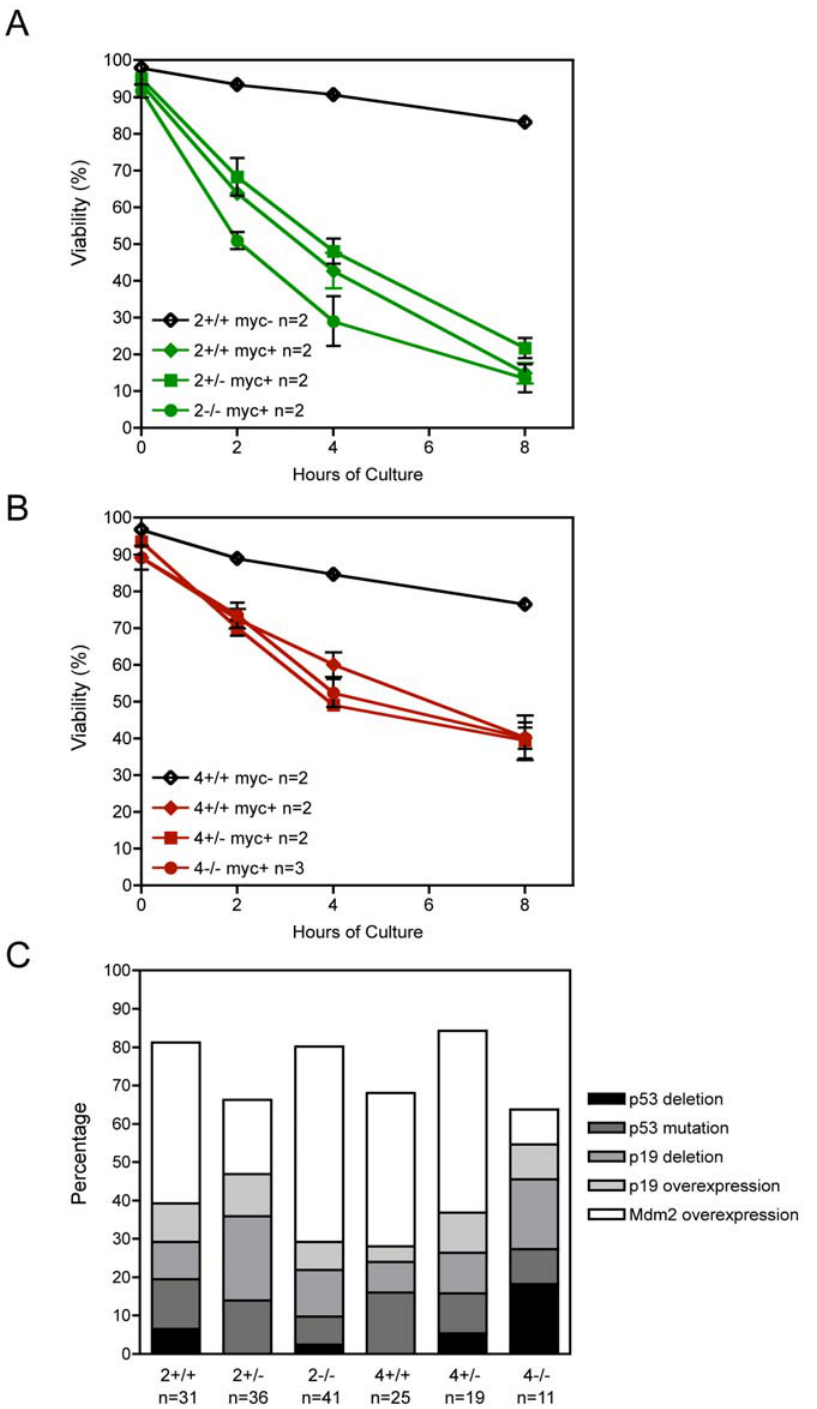
Figure 3. E2F2 and E2F4 do not influence the viability of pretumorous B lineage cells or the incidence of p19Arf-Mdm2-p53 alterations in Myc-induced lymphomas. (A) Representative experiment assessing the viability of B lineage cells (small pre-B and more mature stages) isolated from pretumorous mice of the E2F2 cohort and cultured in the absence of cytokines. Flow cytometry was used to assess viability over time in culture, with B220 + cells negative for both activated caspase 3 and 7-AAD identified as viable. Error bars show standard deviations. (B) Representative experiment assessing the viability of B lineage cells (small pre-B and more mature stages) isolated from pretumorous mice of the E2F4 cohort and cultured in the absence of cytokines. Error bars show standard deviations. (C) Incidence of p53, p19ARF, and Mdm2 alterations in the lymphomas emerging from E m - Myc transgenic mice of the indicated E2F genotypes. p53 and p19ARF deletions were identified by Southern blotting, and p53, p19ARF, and Mdm2 overexpression by western blotting. As p19ARF overexpression can result from loss of p53 function, tumors were counted as having p19ARF overexpression only when independent of p53 mutation or deletion. Mdm2 overexpression was counted only if exclusive of defects in p53 or